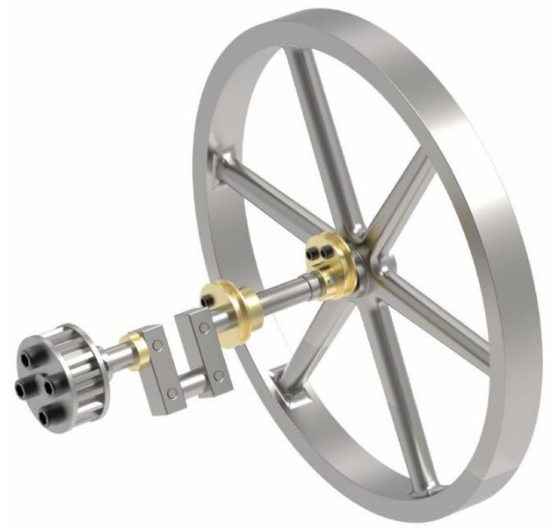
Figure 12. Crankshaft